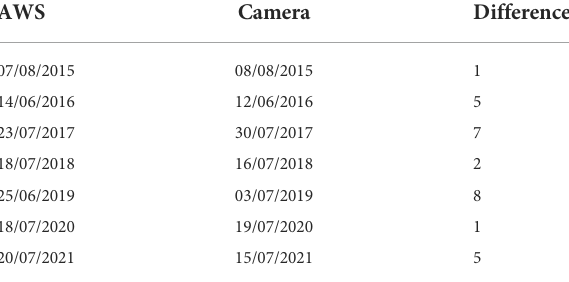
TABLE2 Date according tothe AWSmountedsonicranger sensor and the pressure transducer that appear to indicate no snow at the AWS, compared to the date it appears to be bare ice according to the time-lapse camera imagery. AWS Camera